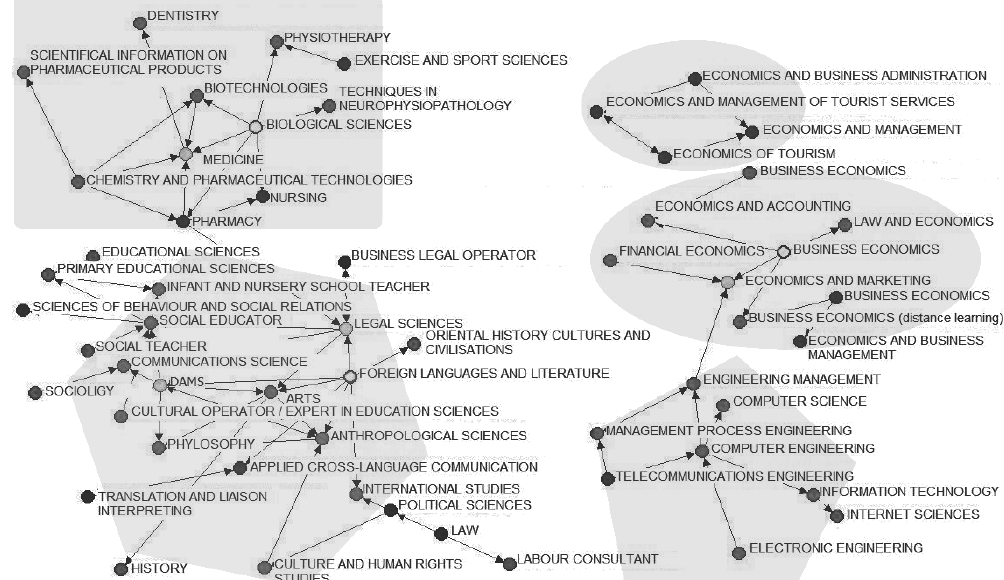
Figure 5 – Semplified network with cut-off (academic year